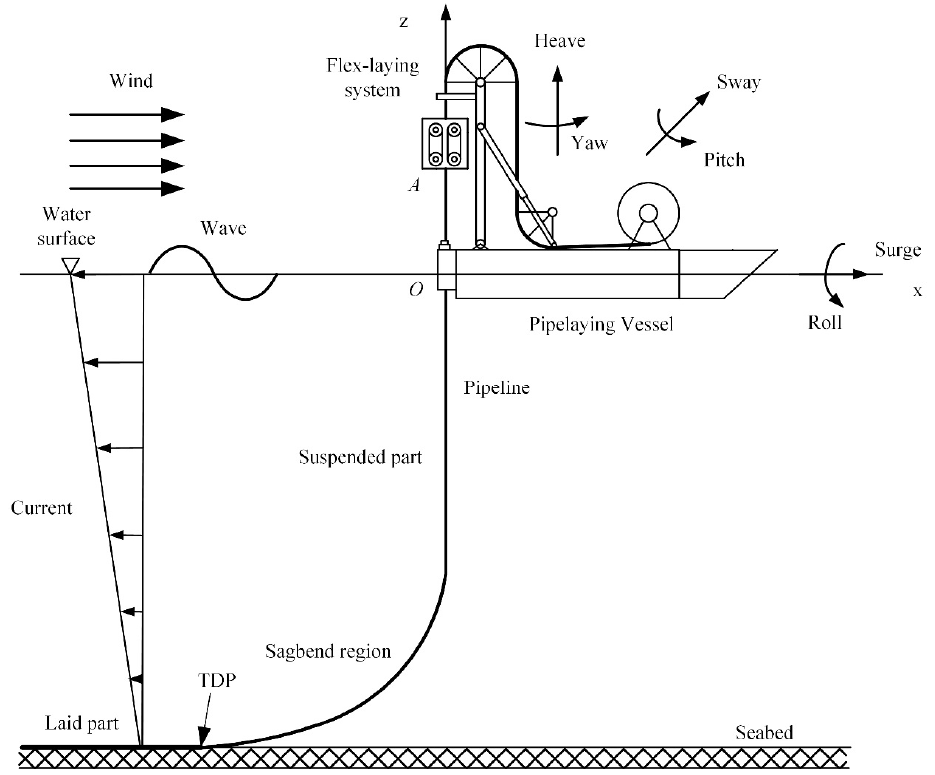
Figure 1. Schematic diagram of Flex ‐ lay pipeline installation.